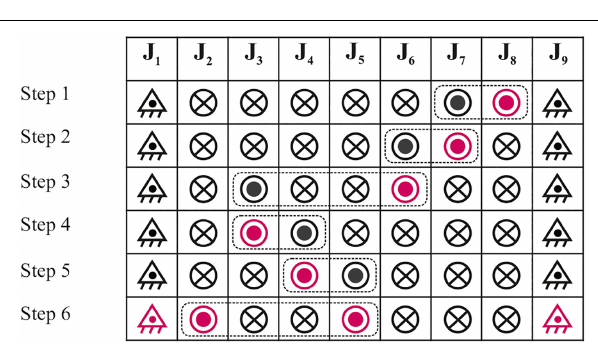
FIGURE 3 | Scheduling table for a control sequence adopted to realize the required shape adjustment ( N : locked joint, (cid:12) : unlocked joint, (cid:52) : pivoted–to–the-ground joint, and shaded symbols represent the currently adjusted